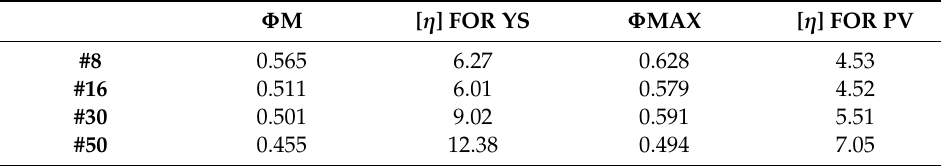
Figure 5. Increase in relative plastic viscosity with increasing volume fraction. Table 7. Fitted values for Krieger-Dougherty equations for yield stress and